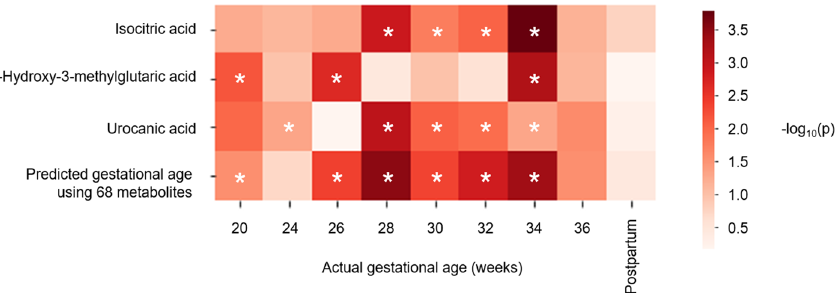
Figure 5. Statistical analyses of associations of urinary metabolites or predicted gestational age with HDP onset. Urinary levels of isocitric acid, 3-hydroxy-3-methylglutaric acid, and urocanic acid, as well as the predicted gestational age, were significantly associated with HDP onset at several weeks of gestation. p -values calculated by the Wald test, adjusted for maternal age and urine type, are shown as a heatmap for each gestational week. Asterisks in panel A indicate statistical significance ( p <